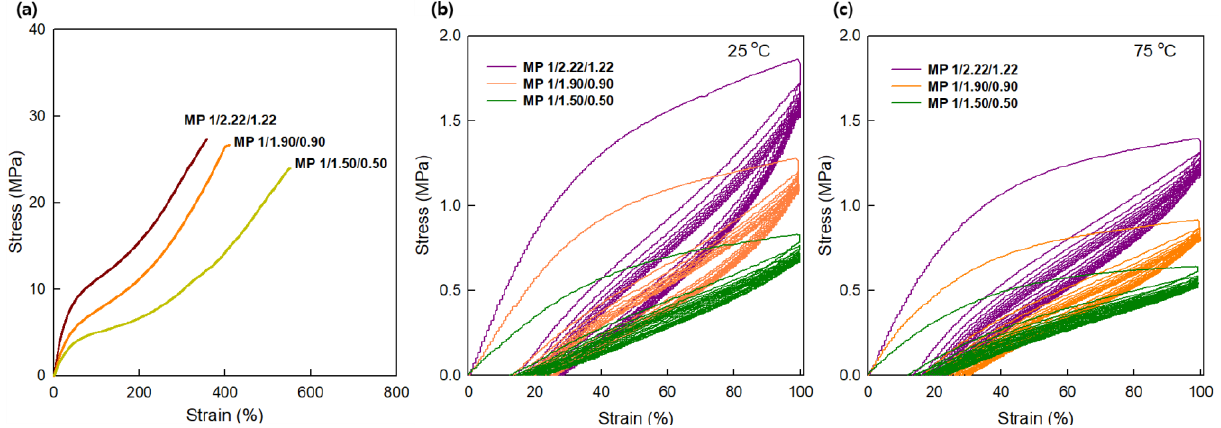
Figure 8. ( a ) Tensile stress–strain curves of the bio-based SMTPUs. Stress–strain hysteresis curves obtained during cyclic testing (applied strain = 100%) at ( b ) 25 °C and ( c ) 75 °C. Table 9. Mechanical properties and hardness values of the bio-based